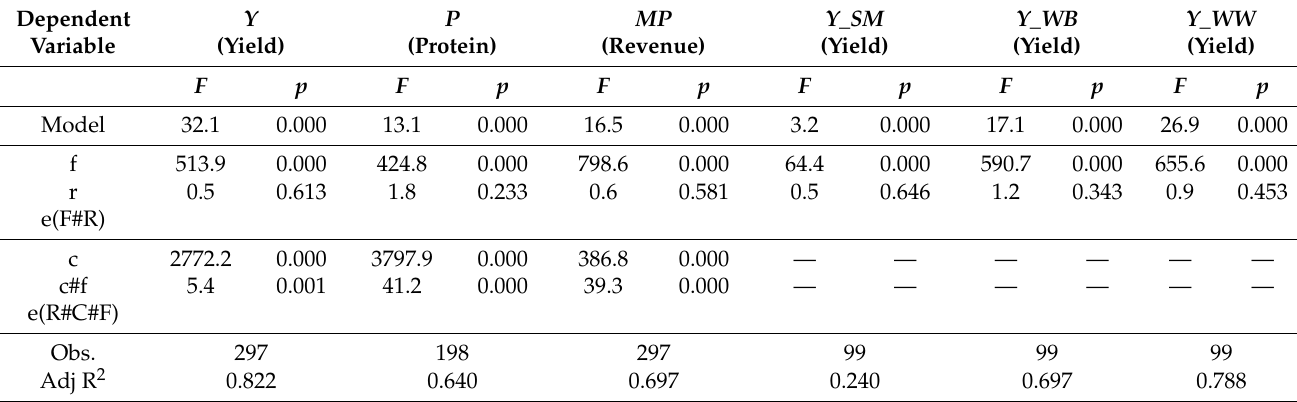
Table 3. Analyses of variance for yield, protein content, and market